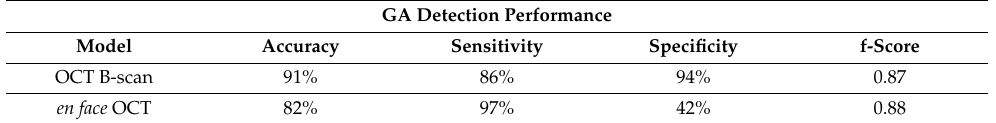
Table 1. Summary of GA detection performance for both OCT B-scan and en face OCT models. GA: Geographic atrophy, OCT: Optical coherence tomography.